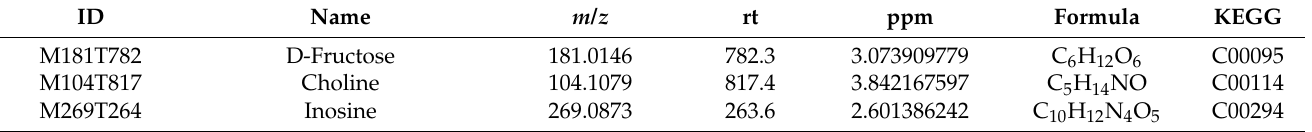
Table 2. Potential metabolites of DXXK in treating DOX-induced myocardial cell